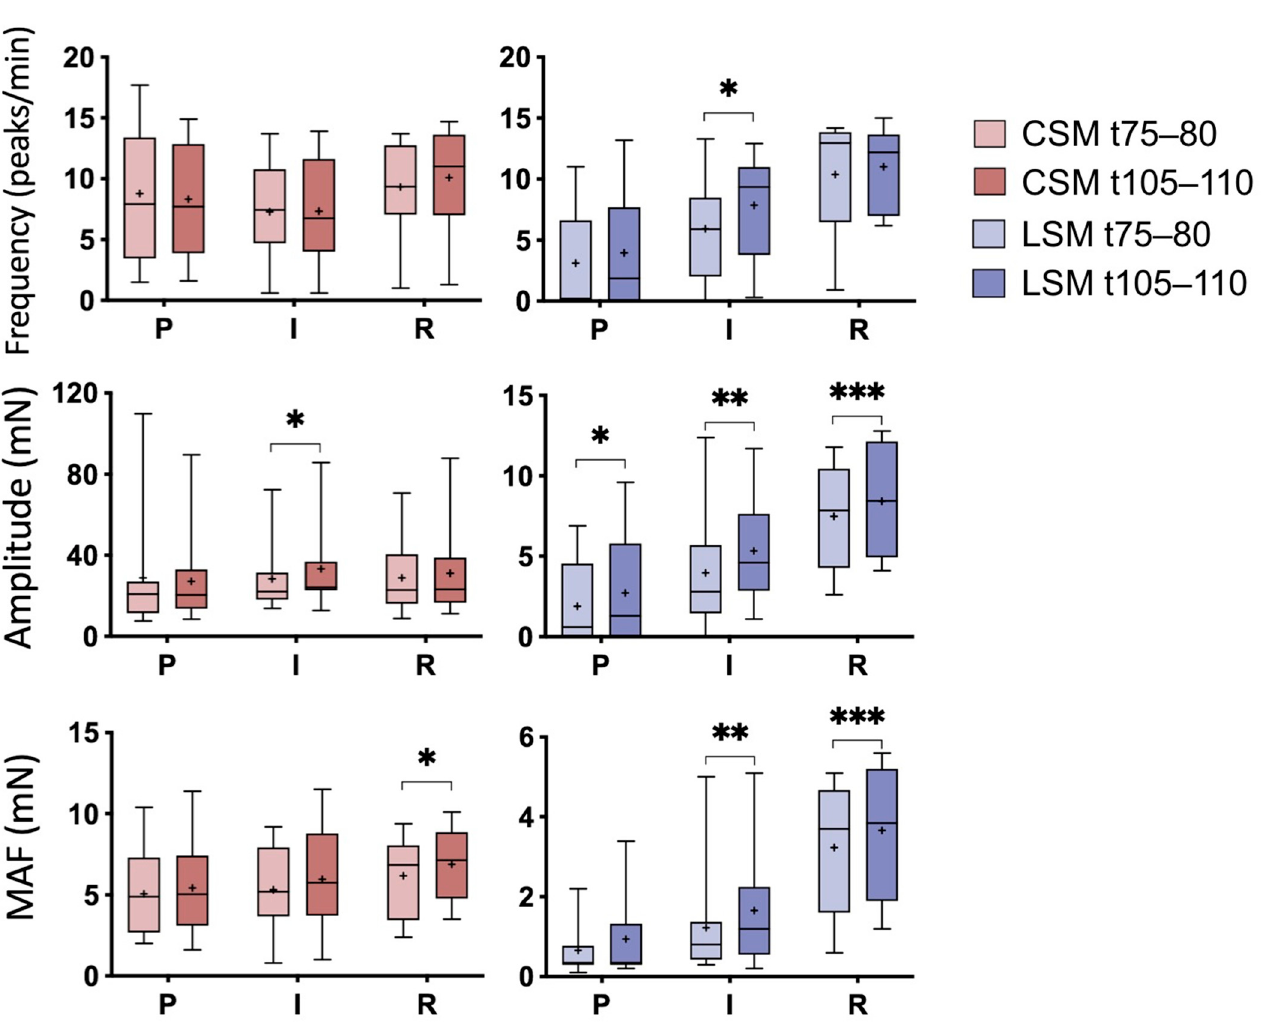
Figure 3. Box plot diagram of the basal contractile activity of jejunal circular smooth muscle (CSM) and longitudinal smooth muscle (LSM) of 12 horses during pre-ischaemia (P), ischaemia (I), and reperfusion (R) at different time points t75–80 and t105–110 during the organ bath experiment. Significant differences between the time points (paired two tailed t -test) are marked with an asterisk (* p < 0.05; ** p < 0.01; *** p < 0.001). The horizontal bar displays the median and the plus is the mean, the interquartile range is represented by the box and the minimum and maximum by the whisker plots. MAF is the mean active force.